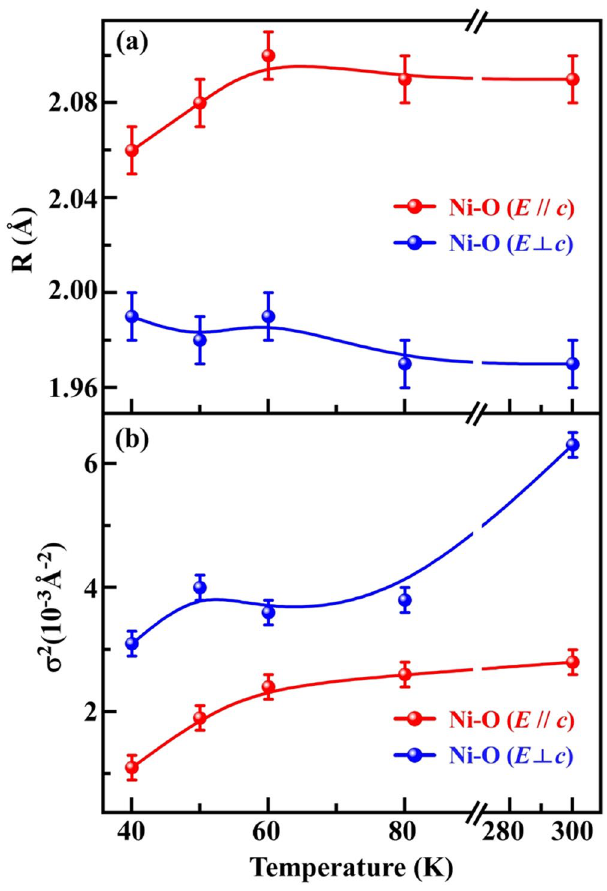
Figure 7. Variation in ( a ) NN Ni-O bond length and ( b ) DWF with temperature, obtained by fitting temperature-dependent Ni K -edge EXAFS spectra for R from 1.26 to 2.30 Å for E // c and E ⊥ c polarizations in